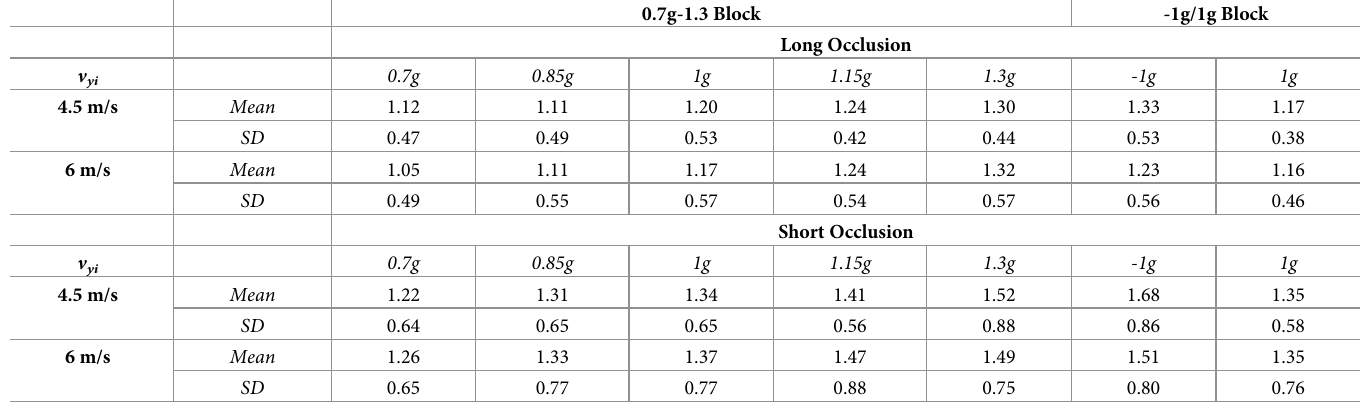
Table 1. Means and standard deviations observed for the temporal errors divided by gravities and initial vertical